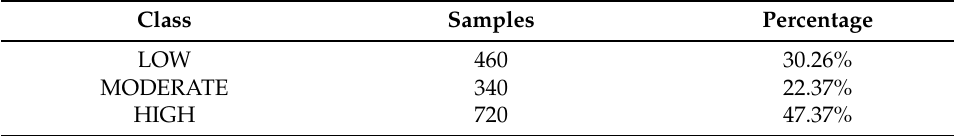
Figure 7. The confusion matrix of the best model for the 3-level stress classification task (single 1D CNN architecture). Table 6. Number of samples per class in test set of best